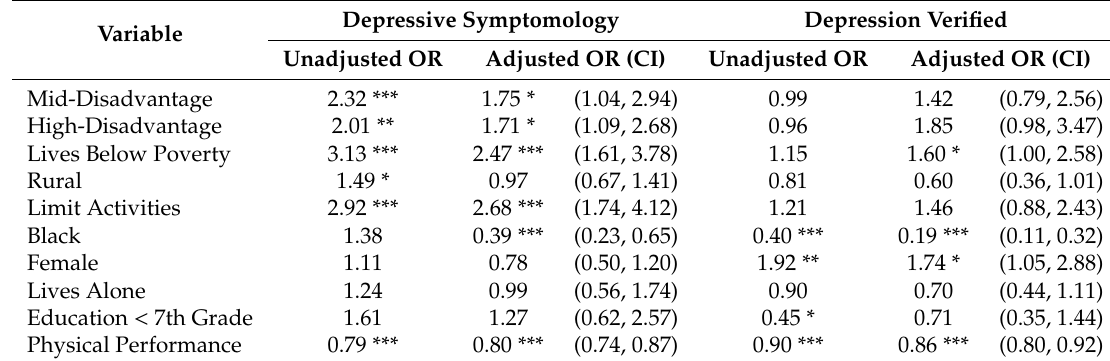
Table 2. Generalized Estimating Equation Results for Neighborhood Disadvantage E ff ects on Depression-related Outcomes ( n = 998).